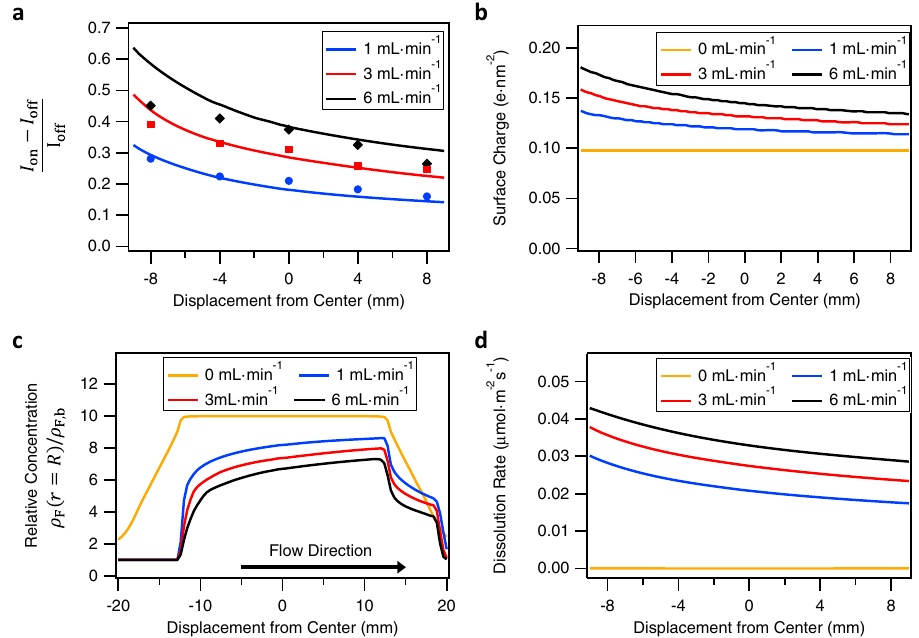
Fig. 6 Results from the numerical model. a Calculated (lines) and experimentally obtained (symbols) relative changes in the v-SFG intensity along the mineral surface for different fl ow rates. We show only the averaged values from Fig. 3 without the spread of the individual data points for clarity. b Calculated surface charge along the mineral surface for different fl ow rates, showing enhancements under fl ow-on conditions by ~50% compared to fl ow-off conditions. c Calculated fl uoride concentration at the surface ρ ð x ; R Þ relative to the bulk along the mineral surface for several fl ow rates. d The F calculated net dissolution rate J ð x Þ along the mineral surface for different fl ow rates. Note the orders of magnitude increase upon turning on the fl ow. Under fl ow-off conditions, the dissolution rate is a small fraction of the maximum dissolution rate j J j (cid:8) 10 (cid:2) 5 k fl ow the net dissolution increases by dis while during several orders of magnitude, to approximately half the maximal dissolution rate j J j (cid:8) k dis . The position is given as displacement from the center with values increasing in the direction of fl ow, indicated by the arrow in panel ( c